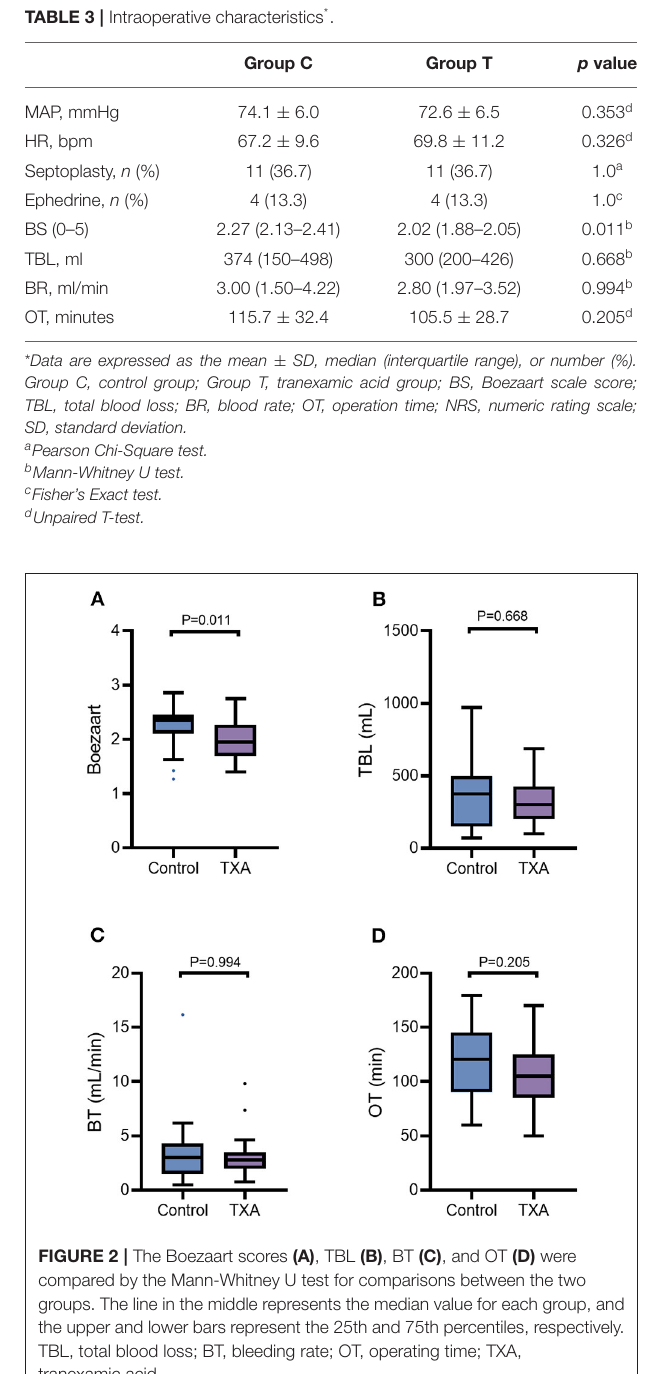
the difference in TBL was not statistically significant